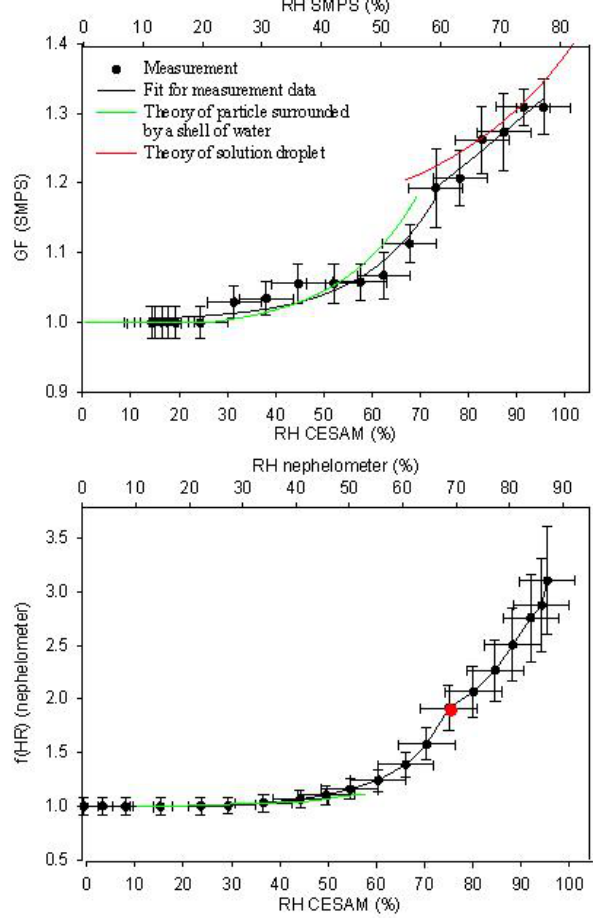
Fig. 11. Hygroscopic growth factor GF (a) and scattering growth factor f (RH) (b) as a function of RH within the chamber (bottom axis) and the RH within the measuring instrument (upper axis) ob- tained for the experiment E1212. The measurements are shown in black circles. The modelled growth factors based on the theory de- scribing ammonium sulfate particle surrounded by a shell of water (red line) and solution droplet (green line) is also added. The black line represents a fit through data